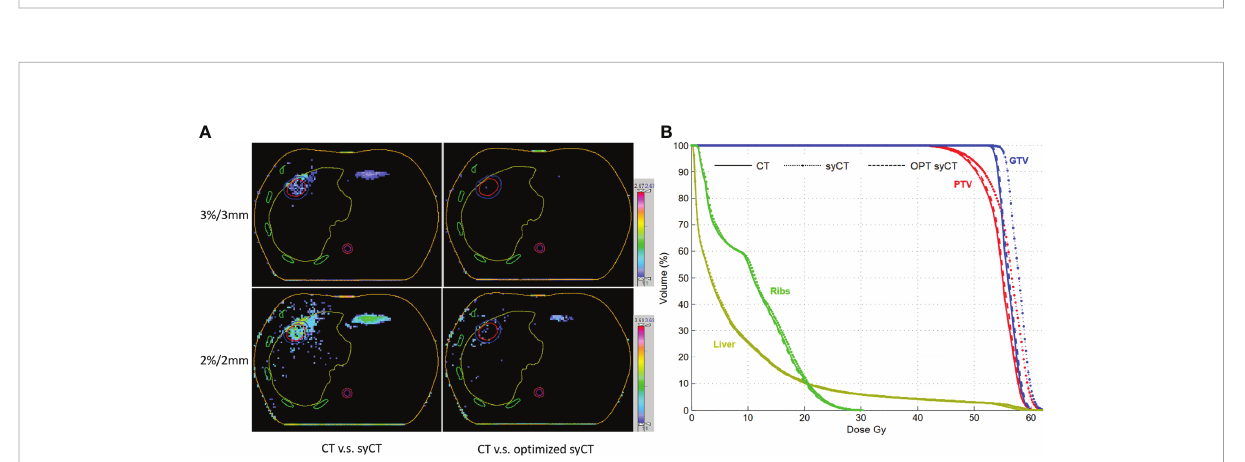
FIGURE 4 The gamma analysis among CT, syCT, and optimized syCT with criteria of 3%/3 mm and 2%/2 mm, respectively (A) ; the comparison of DVH among CT, syCT, and optimized syCT (B)